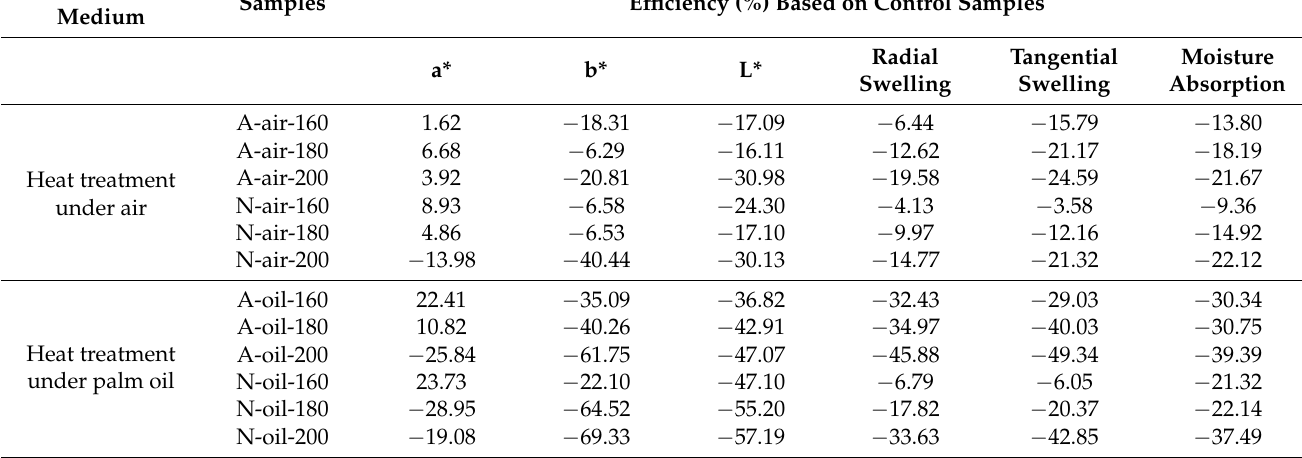
Table 5. Comparison on the efficiency (%) of heat treatment under air and heat treatment under palm oil. Heat